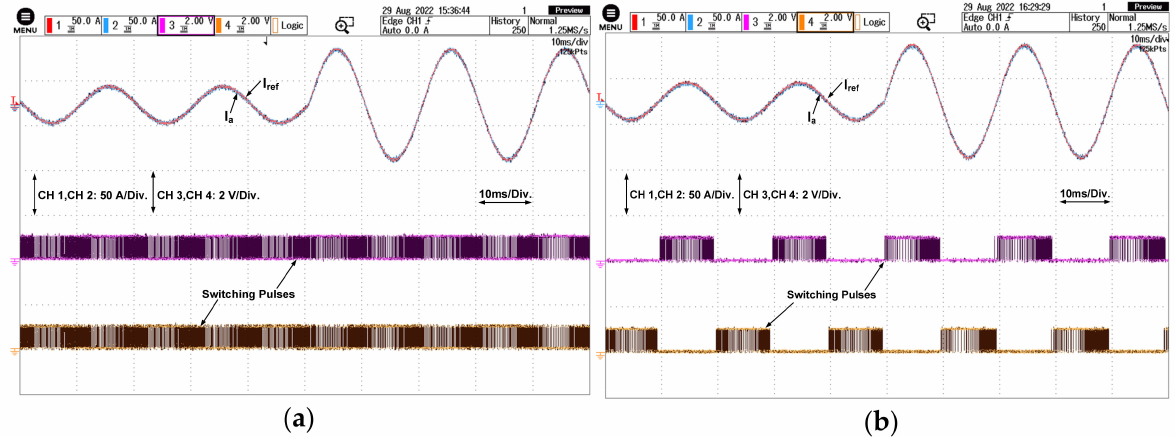
Figure 16. Experimental results showing I ref , I a , and switching pulses under load change for ( a ) IAOA-CHCC and ( b ) IAOA-OFHCC.